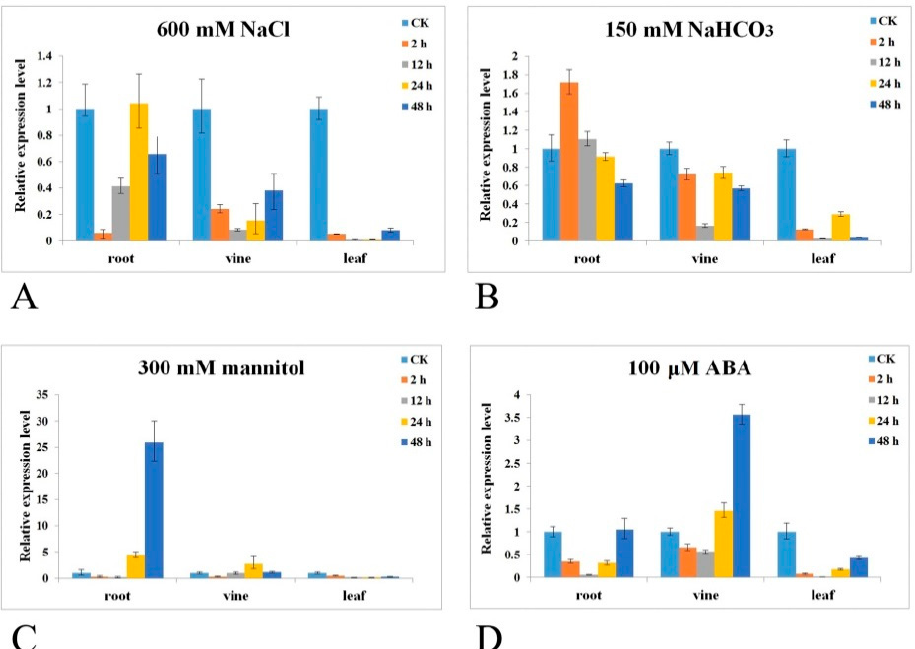
Figure 3. Expression pattern analyses of CrPIP2;3 in C. rosea tissues. Time-course transcriptional levels of CrPIP2;3 in the root, vine, and leaf in response to ( A ) salt; ( B ) salt–alkali; ( C ) high osmotic stress; and ( D ) ABA treatment. Error bars indicate the ± SD based on three replicates. In different tissues under various treatments, all of the expression levels were compared with CK (control check, the beginnings of each treatment).